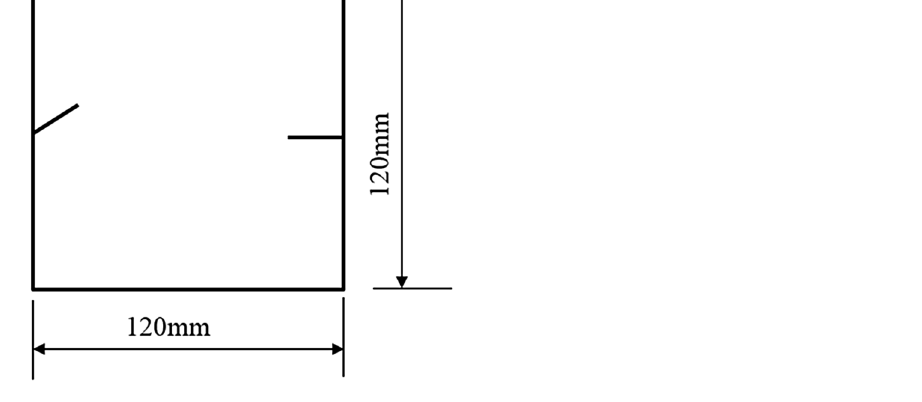
Figure 7. Precast crack orientation 4. Fissure length 2 cm, horizontal angle of fissure